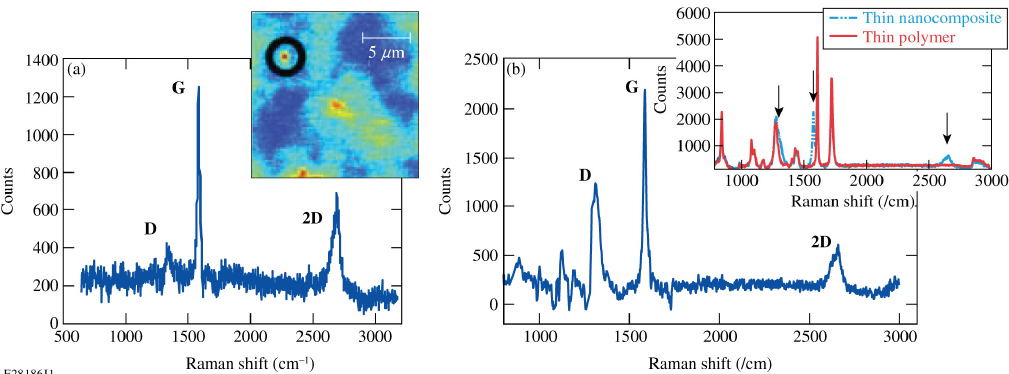
Figure 3. ( a ) Background-subtracted Raman spectrum from a FGL nanoflake embedded in PET-DLA